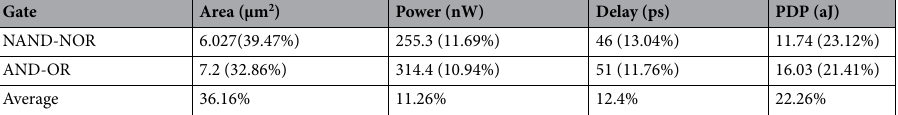
Table 25. Analysis of design overheads for Stack based logic encryption along with % of improvements when compared with proposed logic encryption.